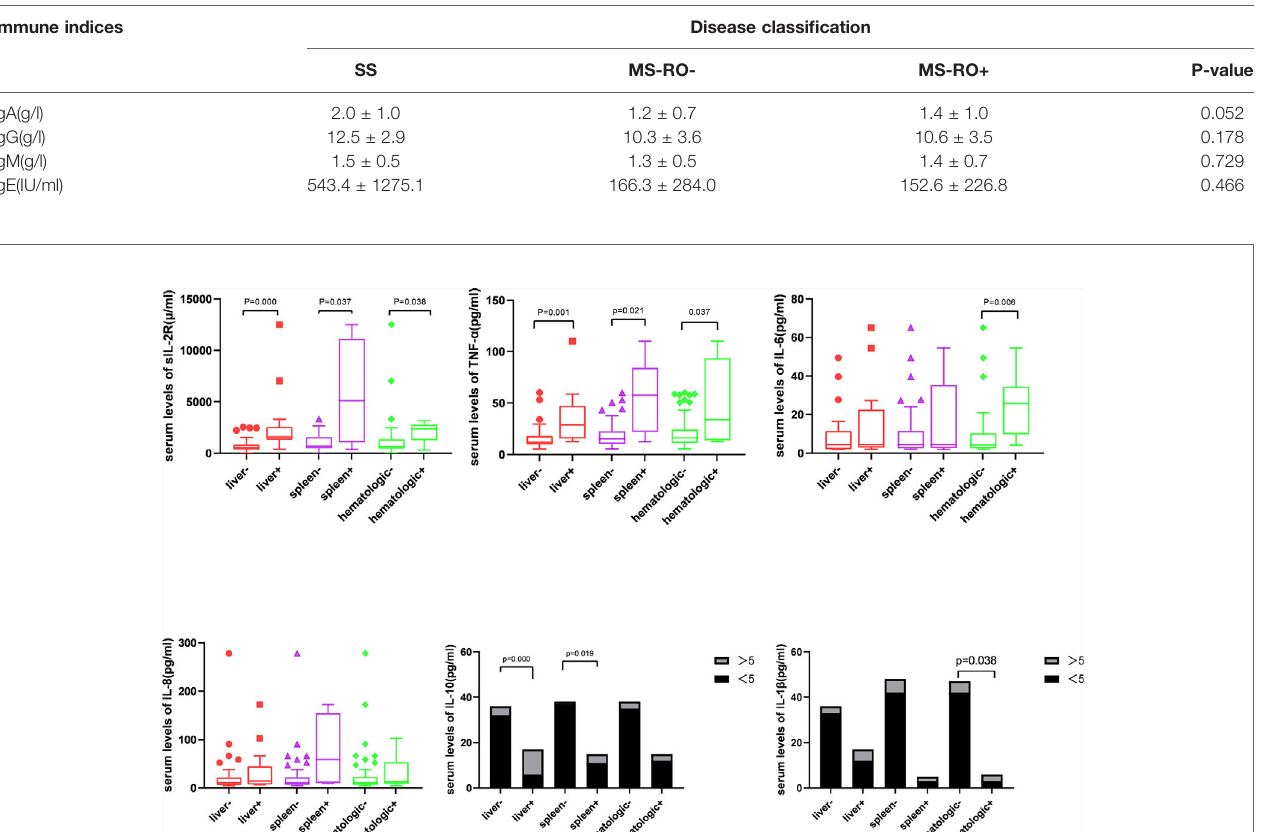
TABLE 2 | Immunoglobulin in different disease classi fi cation.